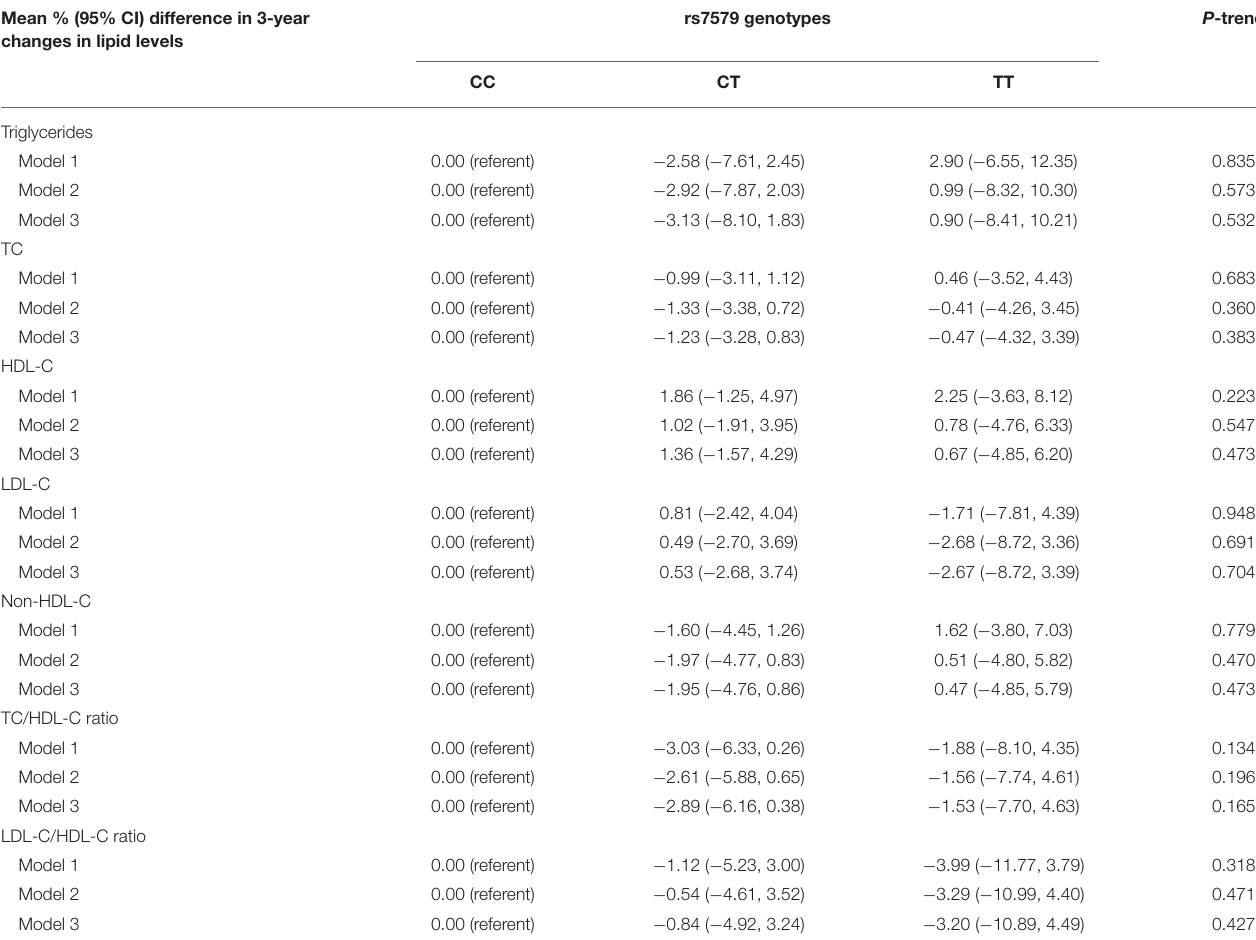
TABLE 3 | Mean % difference (95% CI) in 3-year changes in lipid levels according to rs7579 genotypes a . Mean % (95% CI) difference in 3-year changes in lipid